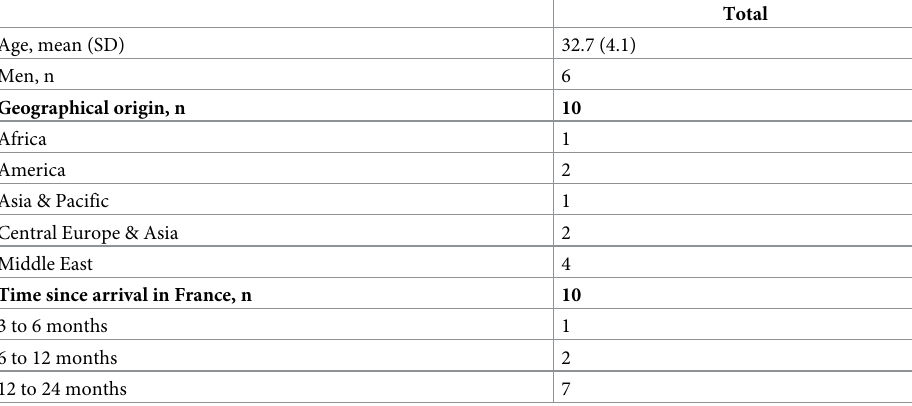
Table 1. Characteristics of the